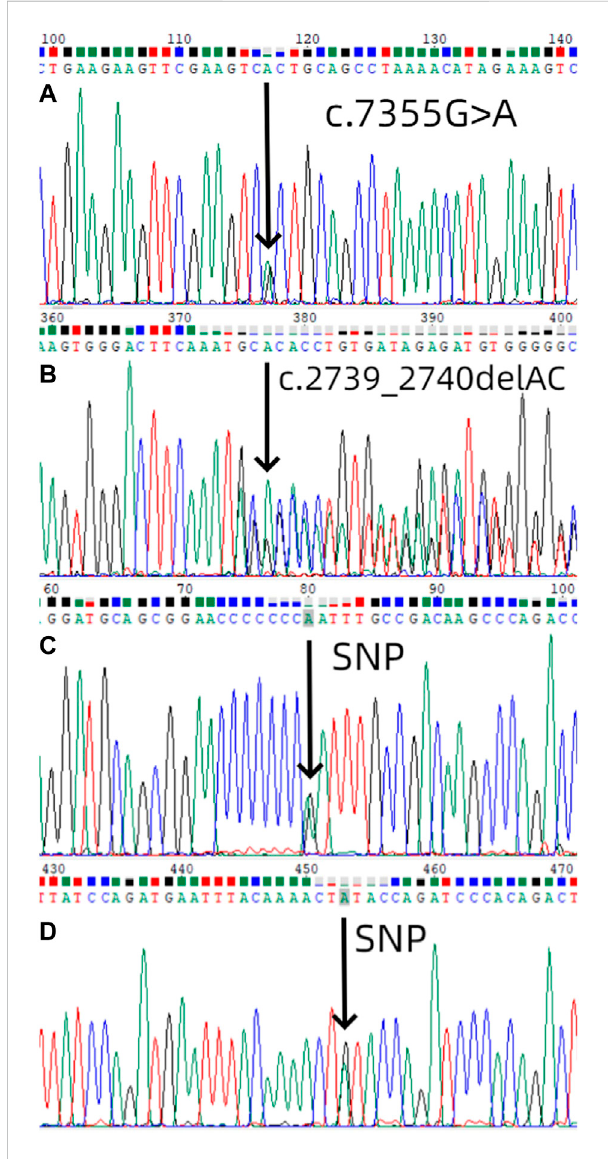
FIGURE 3 Mutation screening. (A) Mutational analysis (next-generation sequencing and direct sequencing for proband) of NF1 in the fi rst family using DNAsequence of exon 50of NF1 genefrom theproband, with an arrow showing [NC_000017.11(NM_001042492.2): c.7355G > A]. The sister and the mother of the fi rst proband also identi fi ed the same mutation. (B) Mutational analysis of NF1 in the second family using DNA sequence of exon 21 of NF1 gene from the proband, with an arrow showing [NC_000017.11(NM_001042492.2): c.2739_2740del]. (C) MutationalanalysisofNF1 inthe fi rst,fourth, fi fth, and sixth families using DNA sequence of exon 18 of NF1 gene from the proband, with an arrow showing [NC_000017.11(NM_ 001042492.2):c.2034G > A]. (D) Mutational analysis of NF1 in the second family using DNA sequence of exon 7 of NF1 gene from the proband, with an arrow showing [NC_000017.11(NM_001042492.2): c.702G >